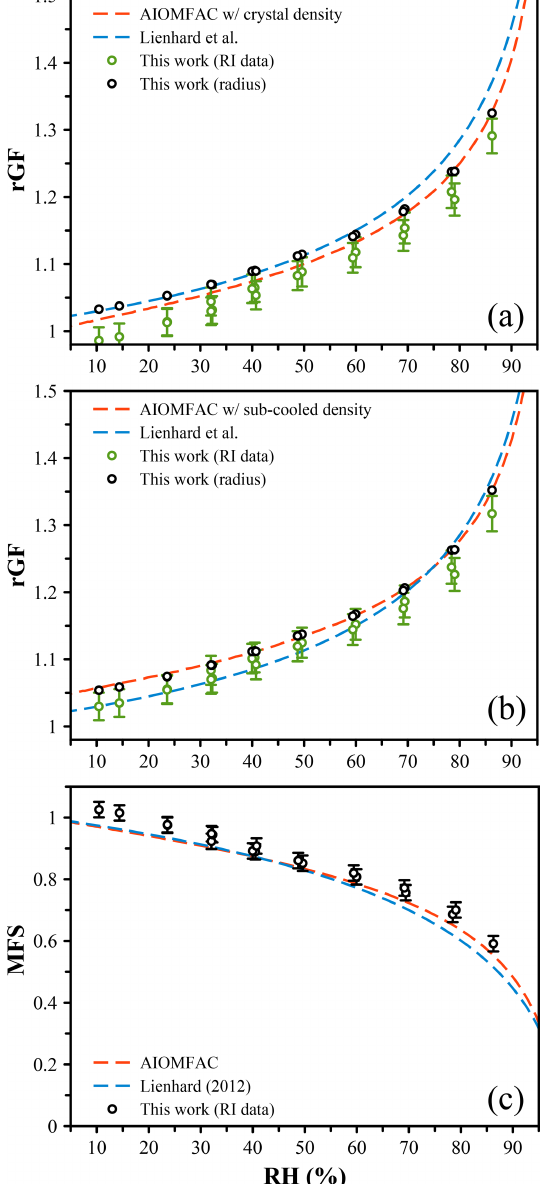
Figure 4. (a) The measured radial growth factor (GF) of citric acid was determined from the radius and constrained to match the AIOMFAC prediction at high RH (black points). The radial GF was derived from AIOMFAC assuming a volume-additive density to convert from mass fraction of solute (MFS) to size (red dashed line). The radial GF inferred from the measured refractive index (RI), using the parameterization of Lienhard et al. (2012) to convert from RI to MFS, is shown with green points. The citric acid density was set equal to the crystal density ( ρ = 1 . 66gcm − 3 ). The rGF cal- culated from the reported density of Lienhard et al. (2012) is shown by the blue dashed line. (b) The same data as in (a) using a den- sity of citric acid in solution equal to the predicted subcooled melt density ( ρ = 1 . 47gcm − 3 ). (c) The MFS derived from the RI (black points), the AIOMFAC model (red dashed line), and the measure- ments of Lienhard et al. (2012) (blue dashed line).